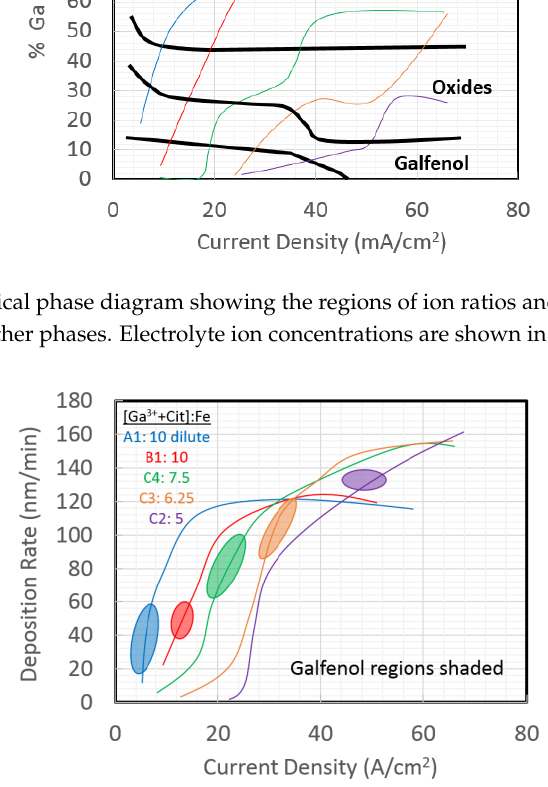
Figure 3. Deposition rates for films from electrolytes that produced Galfenol (shaded regions). Electrolyte ion concentrations are shown in the legend [11].